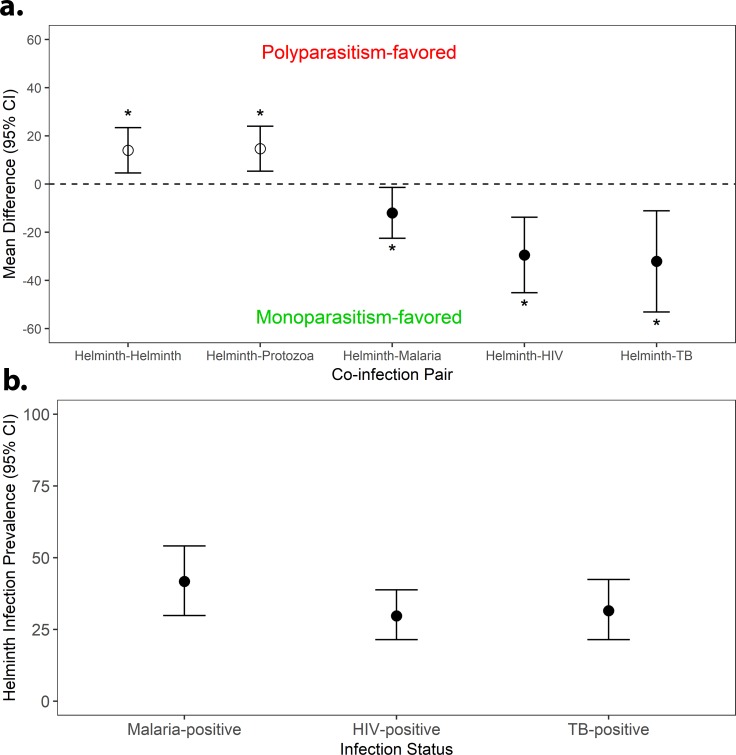
Summary effect sizes and 95% confidence interval plots of (a) the mean prevalence difference between polyparasitized and monoparasitized human hosts with helminth-helminth, helminth-intestinal protozoa, helminth malaria, helminth-HIV, and helminth-TB infections and (b) the proportion of malaria-, HIV- and TB-infected individuals concurrently infected with at least 1 helminth. Open circles indicate studies evaluated community-based differences in prevalence between multiply- and singly- infected individuals, while closed circles indicate studies evaluated the difference in prevalence between helminth co-infected and singly infected malaria, HIV, and TB positive individuals only, respectively. An asterisk denotes statistical significance at the 5% level.